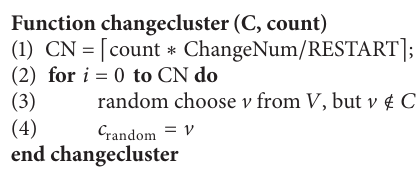
Algorithm 5: The modified VNS algorithm for the 𝑝 -median